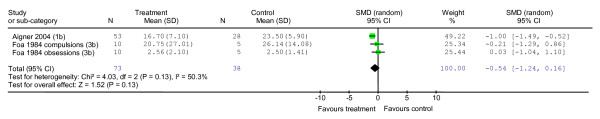
Meta-analysis of anxiety-related effect of net contribution of exposure in vivo based on two OCD studies.